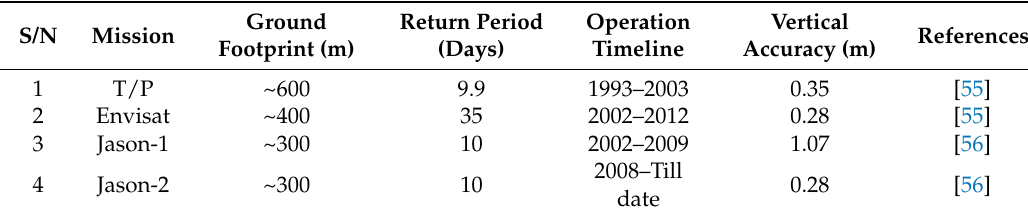
Table 2. Radar altimetry mission and